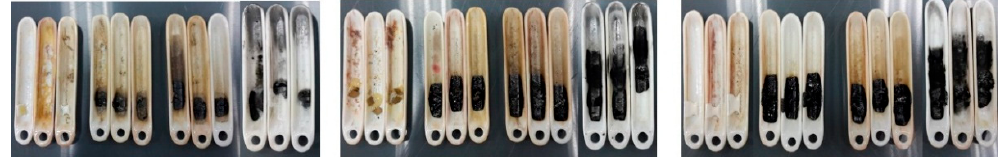
Figure 5. Pictures of pyrolysis char residues of each sample at 300 °C, 400 °C, 500 °C, and 900 °C for the three sample types PPE, TPT, and KPK (from left to right ).